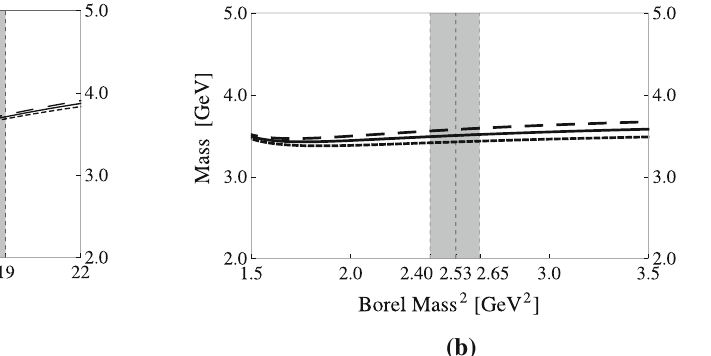
(a) (b) = 2 . 40 / 2 . 53 / 2 . 65 GeV 2 , respectively; b the Fig. 5 The mass M 1 of the state X 1 extracted from the current obtained by setting M 2 B η 1 short-dashed/solid/long-dashed curves are obtained by setting s 0 = α 1 α 2 α 3 α 4 , with respect to a the threshold value s 0 and b the Borel mass M B : a the short-dashed/solid/long-dashed curves are 15 . 0 / 16 . 0 / 17 . 0 GeV 2 , respectively